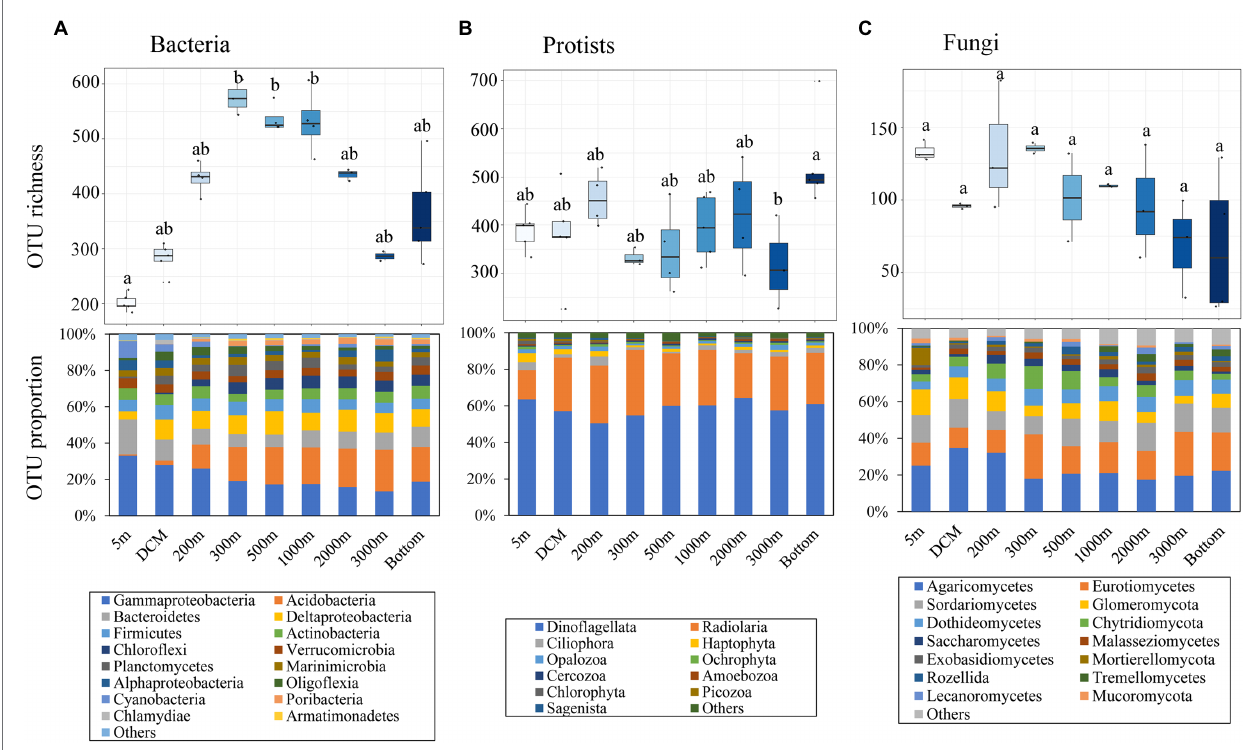
FIGURE 2 | Variations in Operational taxonomic unit (OTU) richness and their corresponding taxonomic identifications (mainly at phylum and class level) along the sampling depth range for (A) bacteria, (B) protists, and (C) fungi. Bottom refers to the max depth of each site. The significant inter-group differences among water layers were annotated above each box with “a,” “b,” or “ab” based on the Fisher’s least significant difference (LSD) test. The phylum/class with the relative OTU proportion more than 0.5% of bacterial, protist, and fungal communities is shown in barplots, and others included taxa with the relative proportion less than